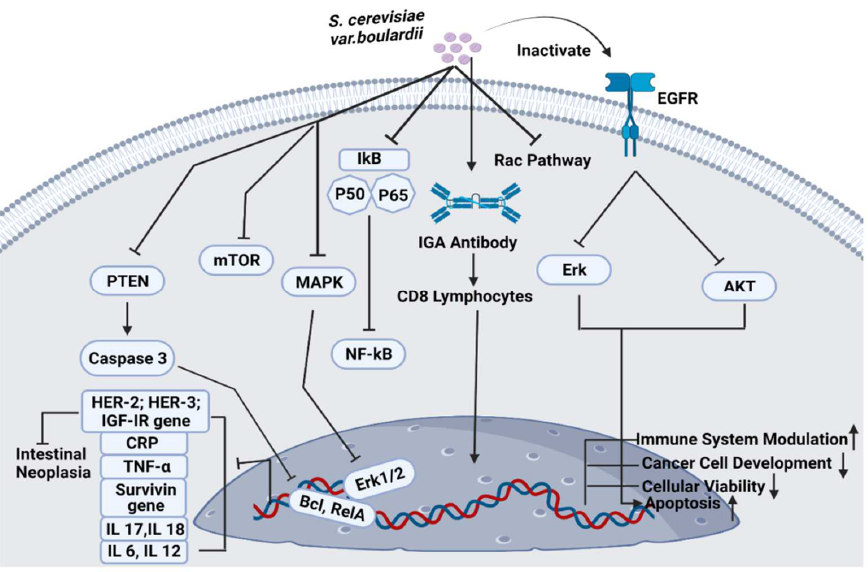
Figure 4. Pathways associated with S. cerevisiae var.